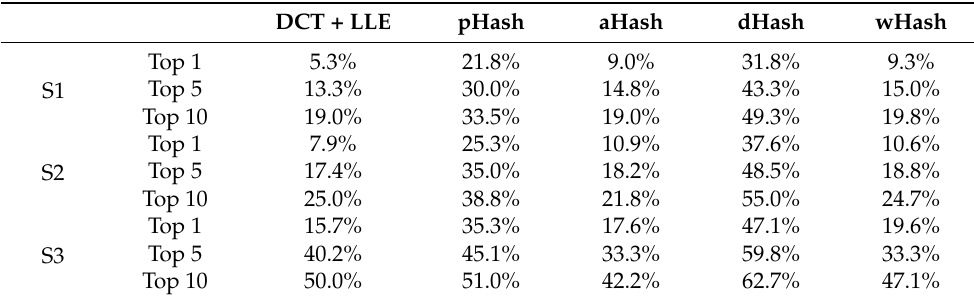
Table A3. Correct matches results for Database vs TS1 comparison—with Radon transform or without contrast stretching application (256-bit).